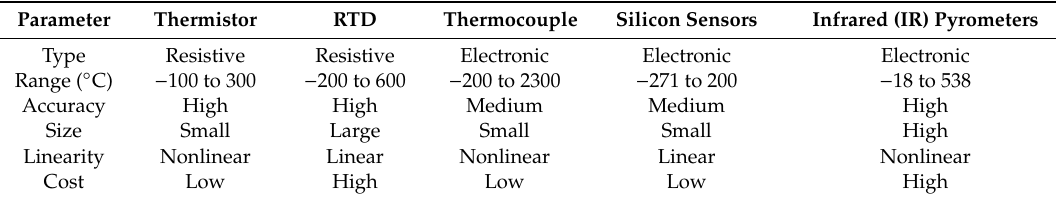
Table 3. Resistive and electronic temperature sensor